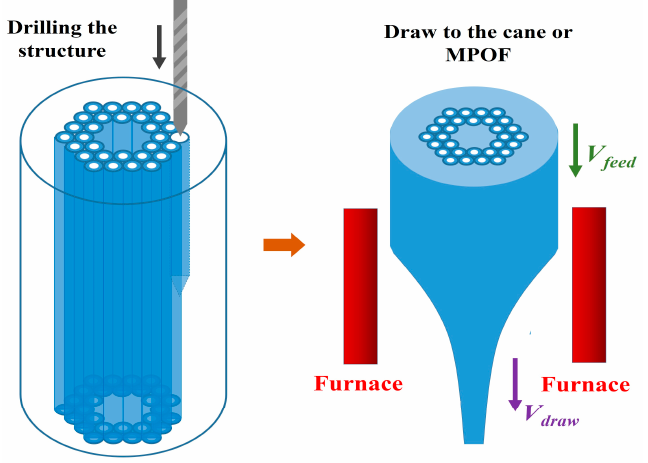
Figure 3. Schematic of the drilling method used to fabricate MPOFs and their preform.